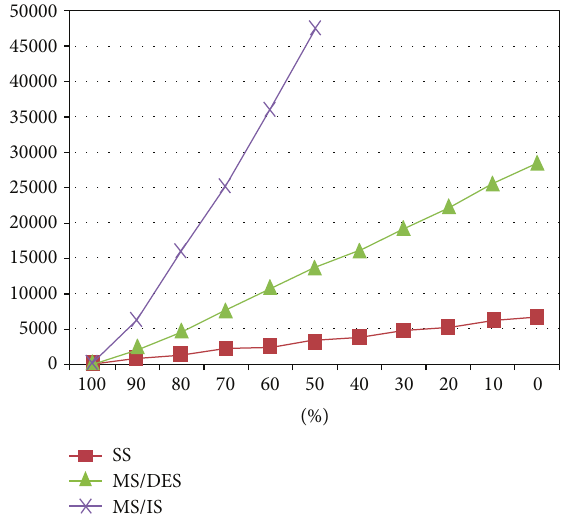
Figure 6: Results of various performance metrics related with query and response numbers.